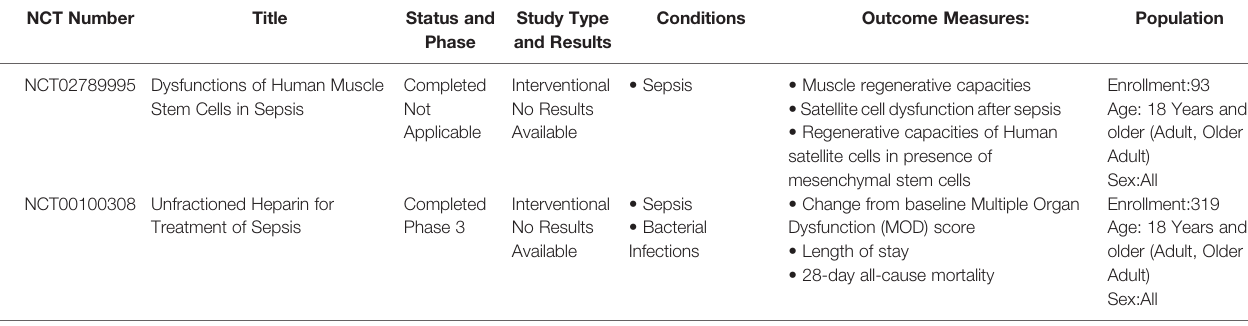
TABLE 1 | Selected Clinical Studies Examining Effects MSCs of Relevance to